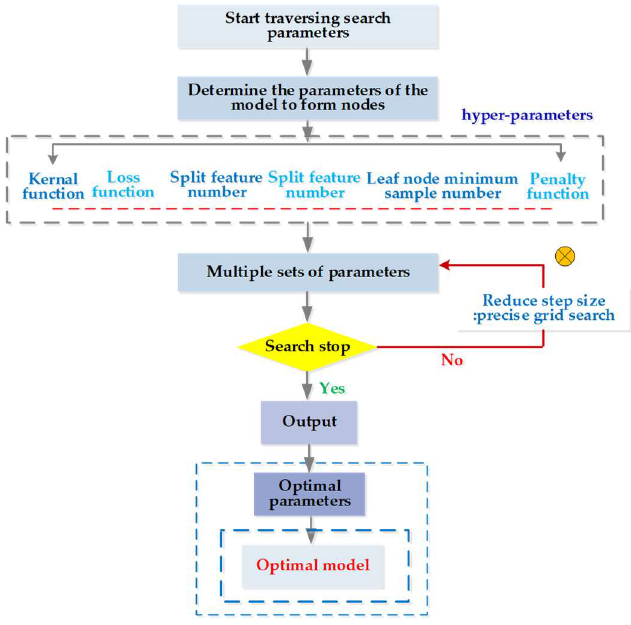
Figure 3. Parameters optimization flow in the grid search optimized